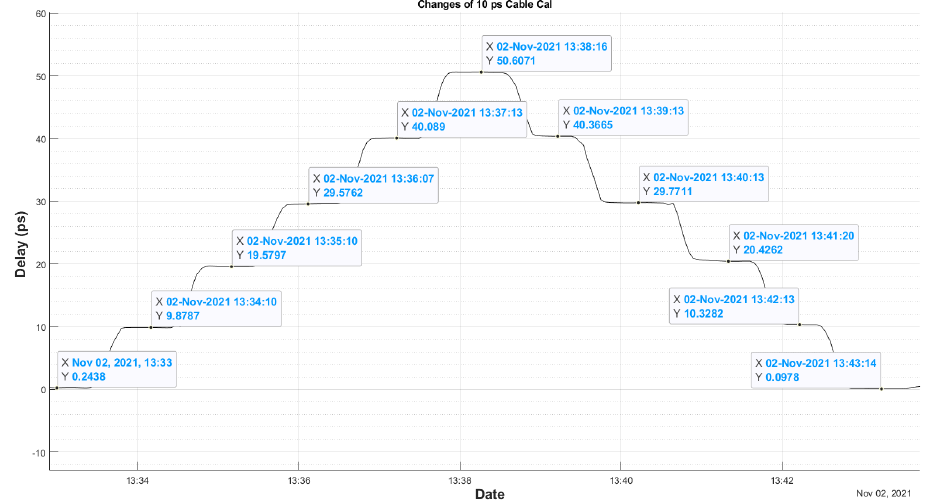
Figure 8. Phase Cal GU response to changes of 10 ps controlled by a phase